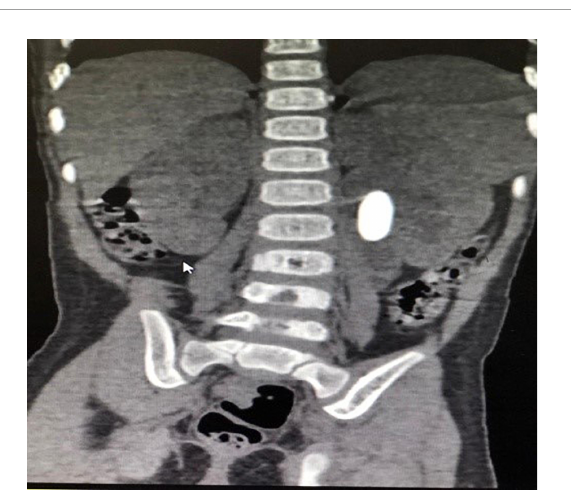
FIGURE2 CT KUB showing hydronephrotic left kidney (PD-13.1 mm), with 2.4 cm × 1.1 cm oval calculus, normal ureter.